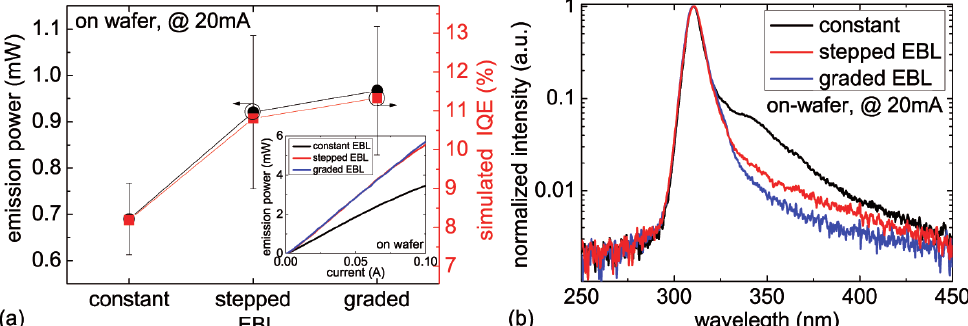
Figure 4. ( a ) measured average emission power (at 20 mA, on-wafer) as well as simulated IQE and ( b ) typical normalized emission spectra (at 20 mA, on-wafer) of 310 nm LEDs with different profiles of the aluminum composition in the EBL. Inset in ( a ): typical emission power vs. current characteristics of 310 nm LEDs with these different EBL